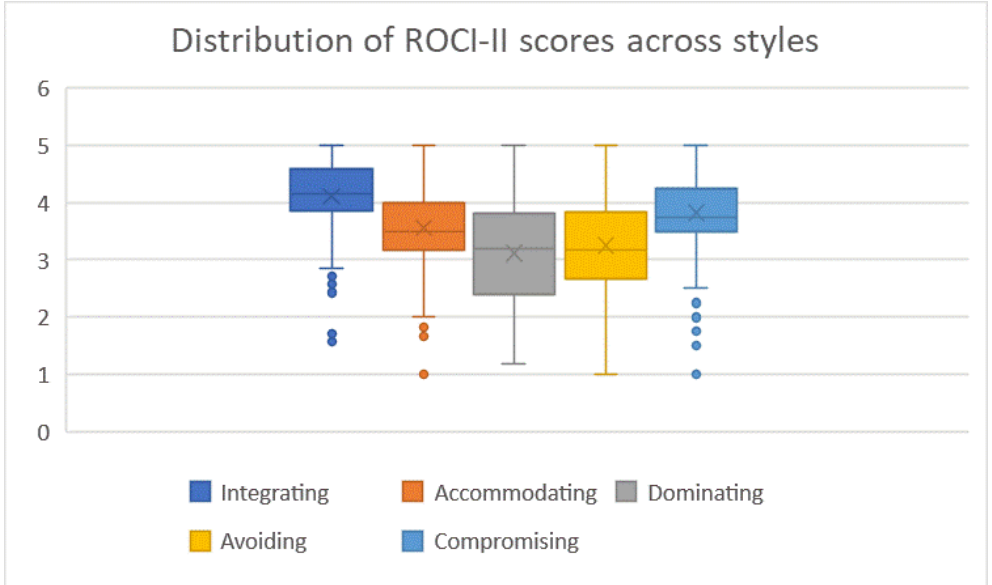
Figure 3. Distribution of the ROCI-II scores obtained by the participants for each negotiation